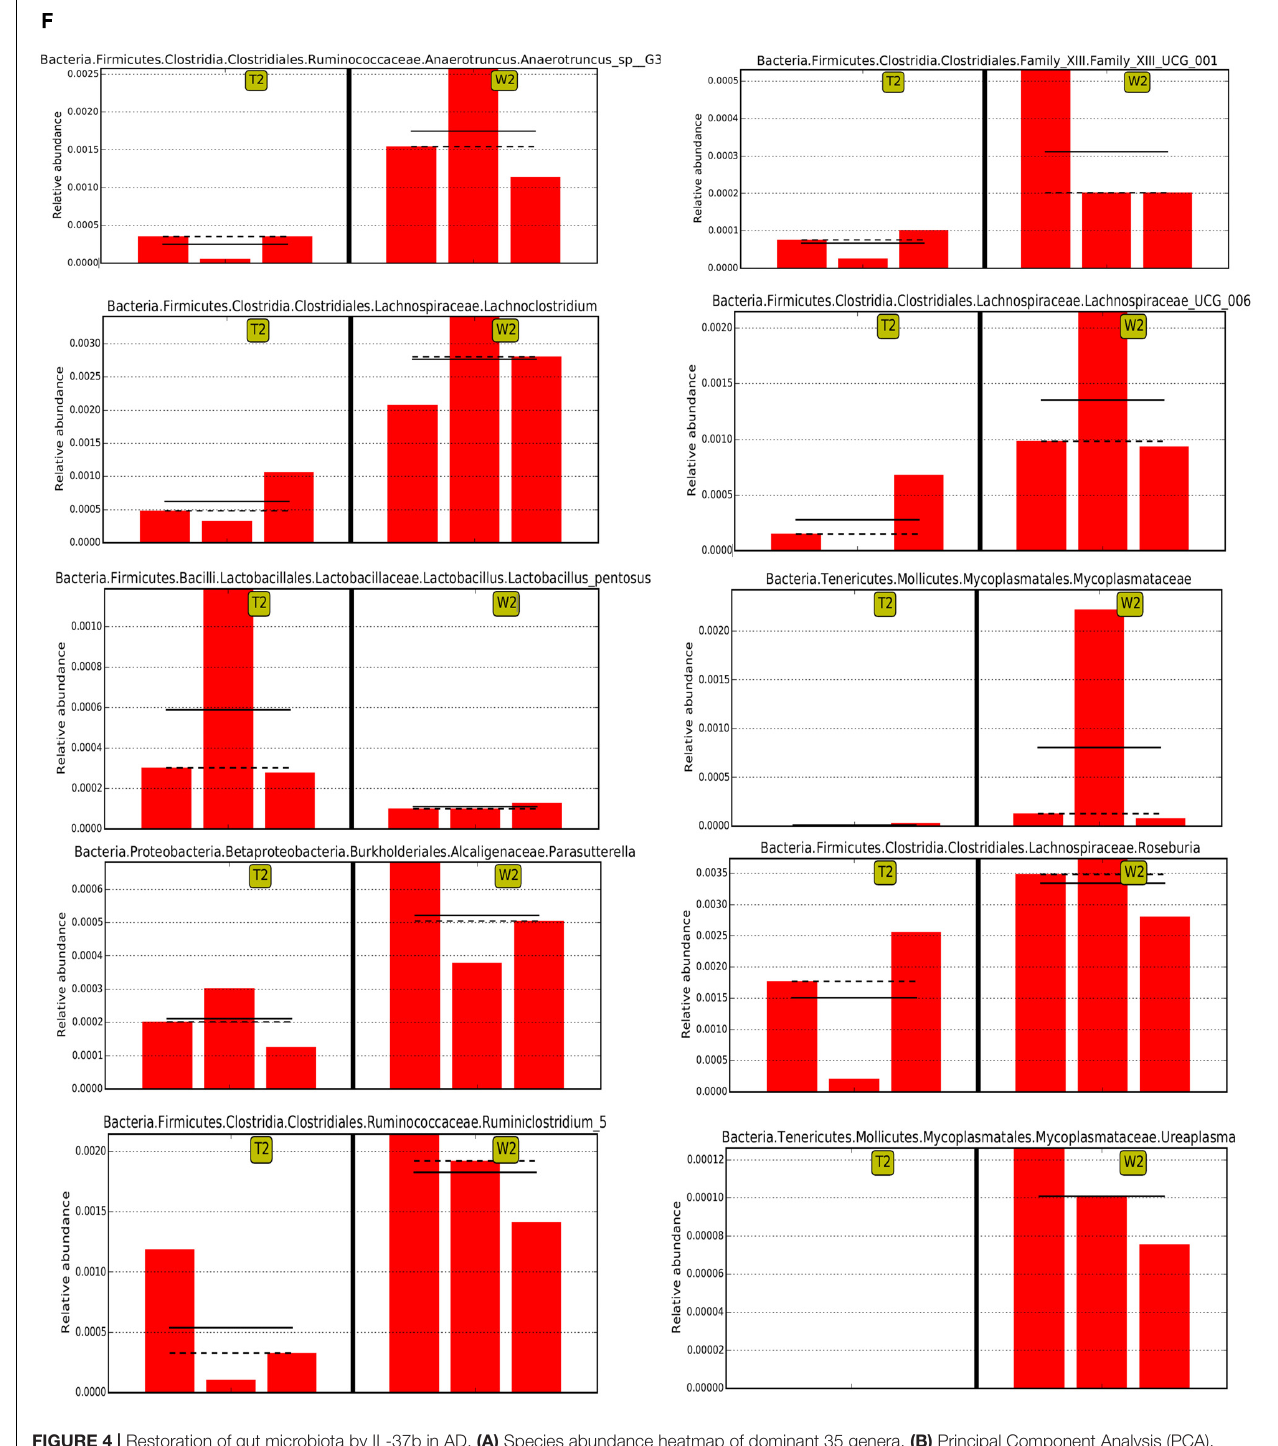
FIGURE 4 | Restoration of gut microbiota by IL-37b in AD. (A) Species abundance heatmap of dominant 35 genera. (B) Principal Component Analysis (PCA). (C) Non-Metric Multi-Dimensional Scaling (NMDS). When the value of Stress factor is less than 0.2, it is considered that NMDS is reliable. (D) Unweighted Pair-group Method with Arithmetic Means (UPGMA) cluster tree based on Unweighted Unifrac distance (1) and Weighted Unifrac distance (2). (E) Histogram of LDA scores. (F) Bar chart of the relative content of representative pathogenic bacteria between W2 and T2. W1, stool samples of wild type mice at day 1 without MC903 stimulation; T1, stool samples of IL-37b Tg mice at day 1 without MC903 stimulation; W2, stool samples of wild type mice at day 17 with MC903 inducing AD model; T2, stool samples of IL-37b Tg mice at day 17 with MC903 inducing AD model. Bar charts are shown with triplicate independent experiments ( n = 1 mouse in each